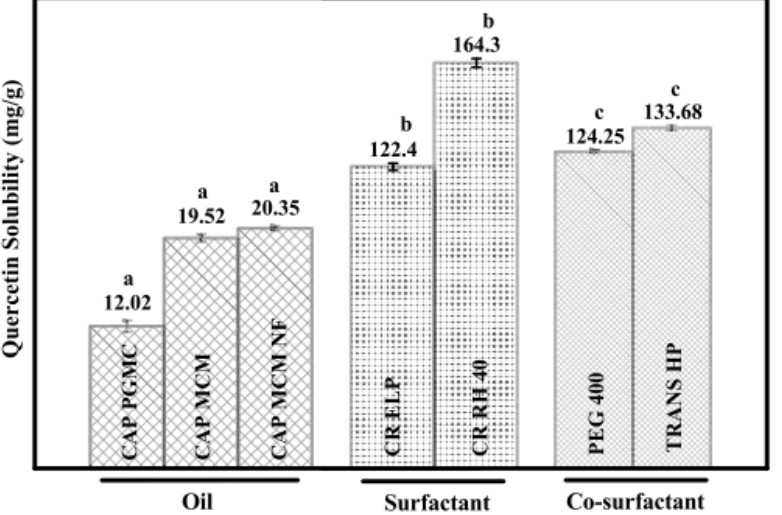
Figure 9. Solubility of quercetin in oils, surfactants, and cosurfactants. Different lower-case letters between the groups (oil, surfactant, and co-surfactant) are significantly different from each other ( p < 0.05, n = 3, error bars show standard deviation)[46].